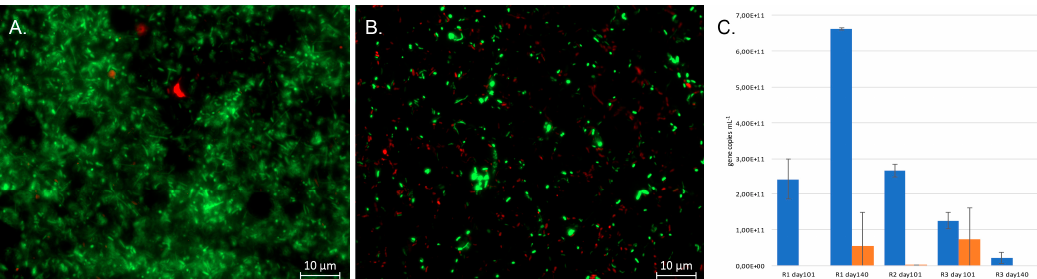
Figure 3. Live/Dead images of the effluents of Reactors 1 ( A ) and 3 ( B ) at the end of the experiment. Green indicates live cells and red are dead cells. The size marker is 10 µm. ( C ) The concentration of bacterial 16S rRNA gene copies (blue) and dsr B gene copies (orange) in the effluents (mL − 1 ) estimated by qPCR. The error bars show standard deviation and each bar represents the average value of 3 replicate qPCR reactions.